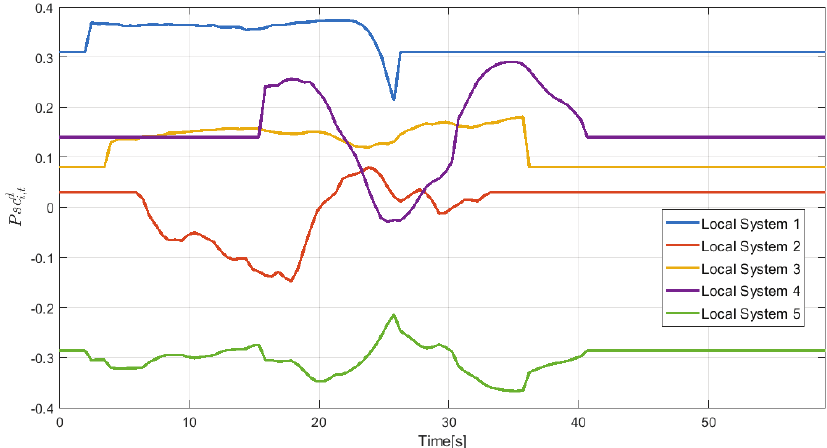
Figure 5. Deterministic part of the net load, Psc d data on each local load), data on each local system.